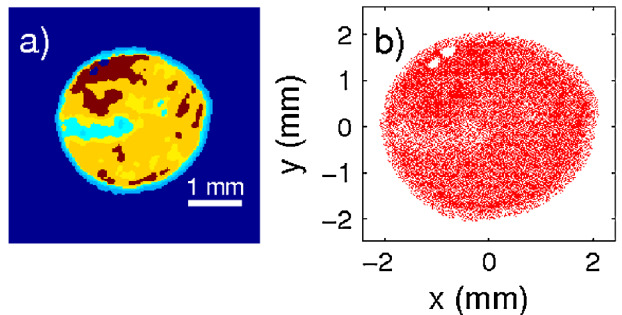
14. (Color) Example of measured transverse laser intensity distribution (a) and corresponding generated macroparticle dis- tribution (b). Note that only 20 000 macroparticles are displayed for